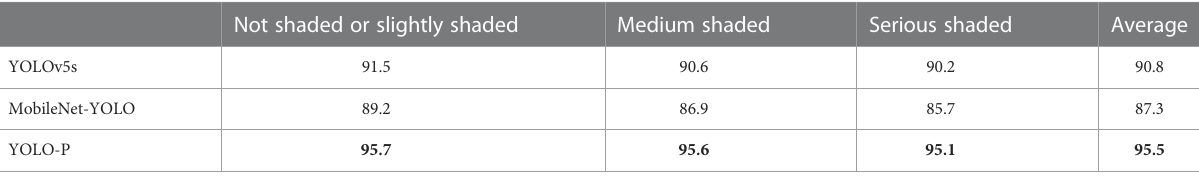
TABLE 9 F1 score (%) in different shaded degrees experiments during nighttime. Not shaded or slightly shaded Medium shaded Serious shaded Average